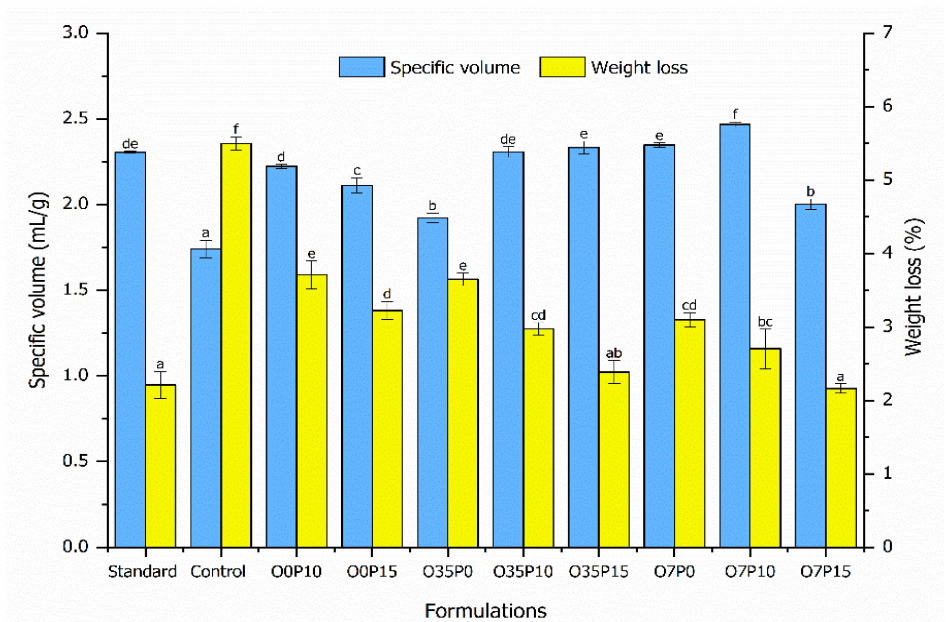
Figure 2. Specific volume (mL/g) and weight loss (%) of different formulations of Saba banana flour cake. Histogram with different alphabet (a–f) indicates significant difference ( p <